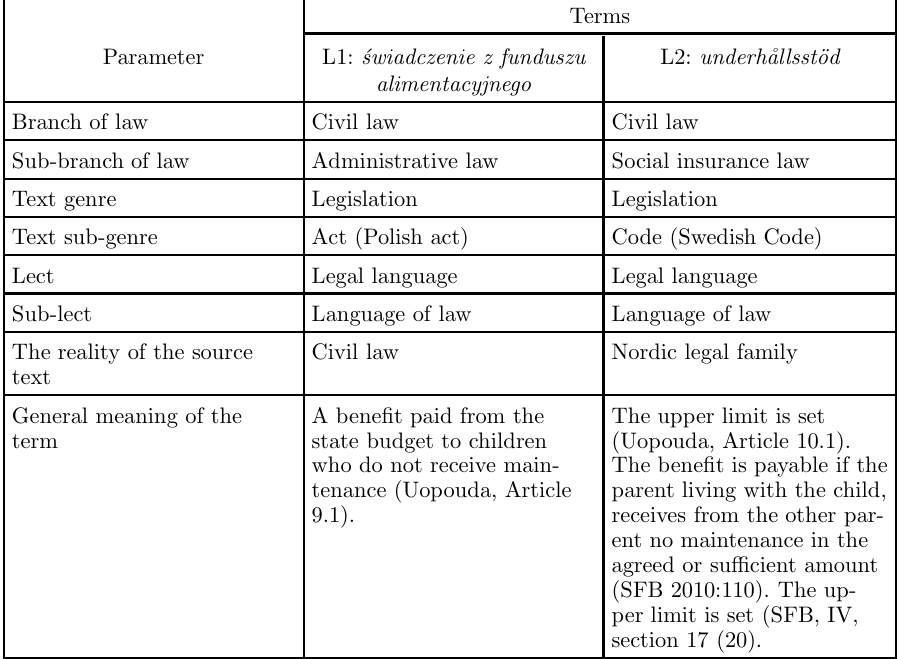
Parametric characteristics of the terms świadczenie z funduszu alimentacyjnego and underh˚allsst¨od Terms Parameter L1: świadczenie z